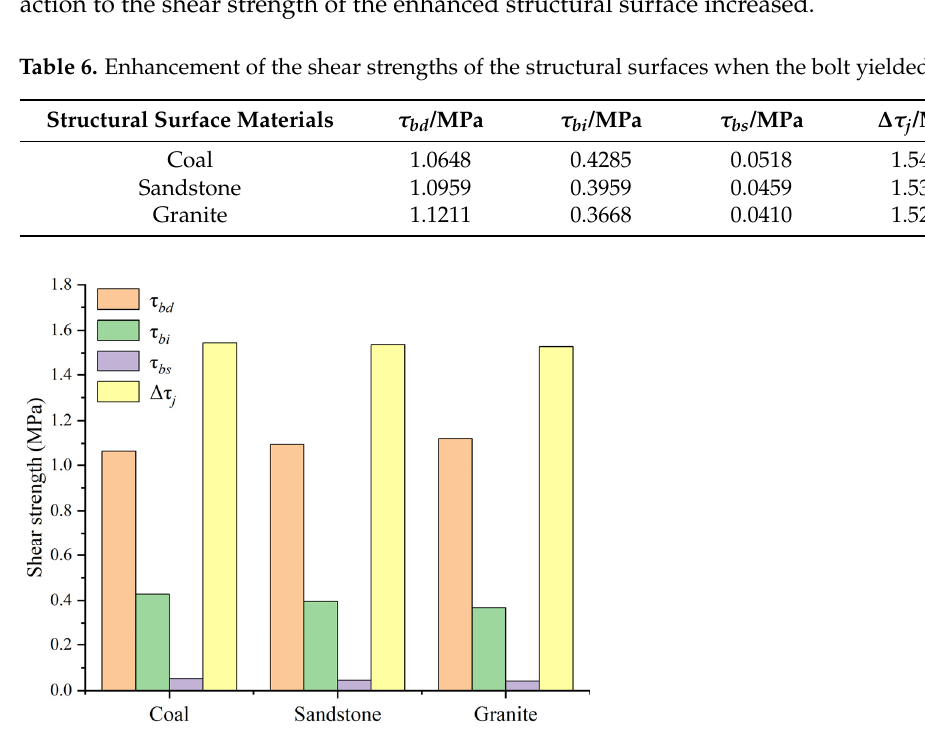
Figure 16. Shear strengths of structural surfaces when bolt